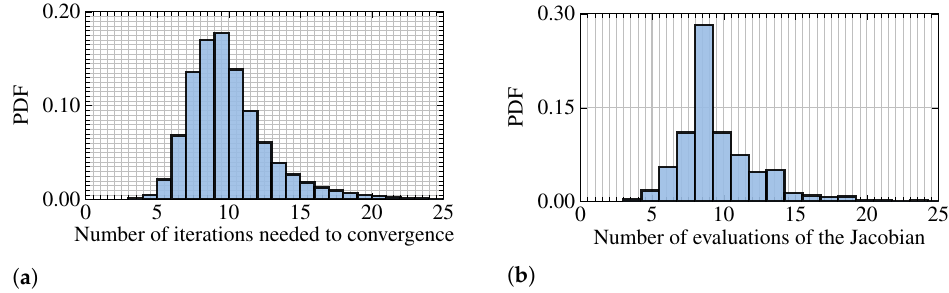
Figure 4. PDF of ( a ) the number of iterations and ( b ) evaluations of the Jacobian of the objective function performed by the